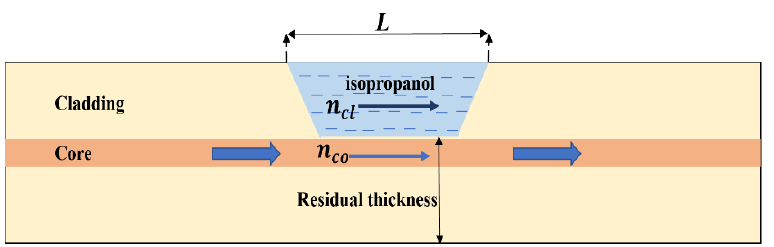
Figure 4. Schematic diagram for the proposed side-polished fiber filled with isopropanol.